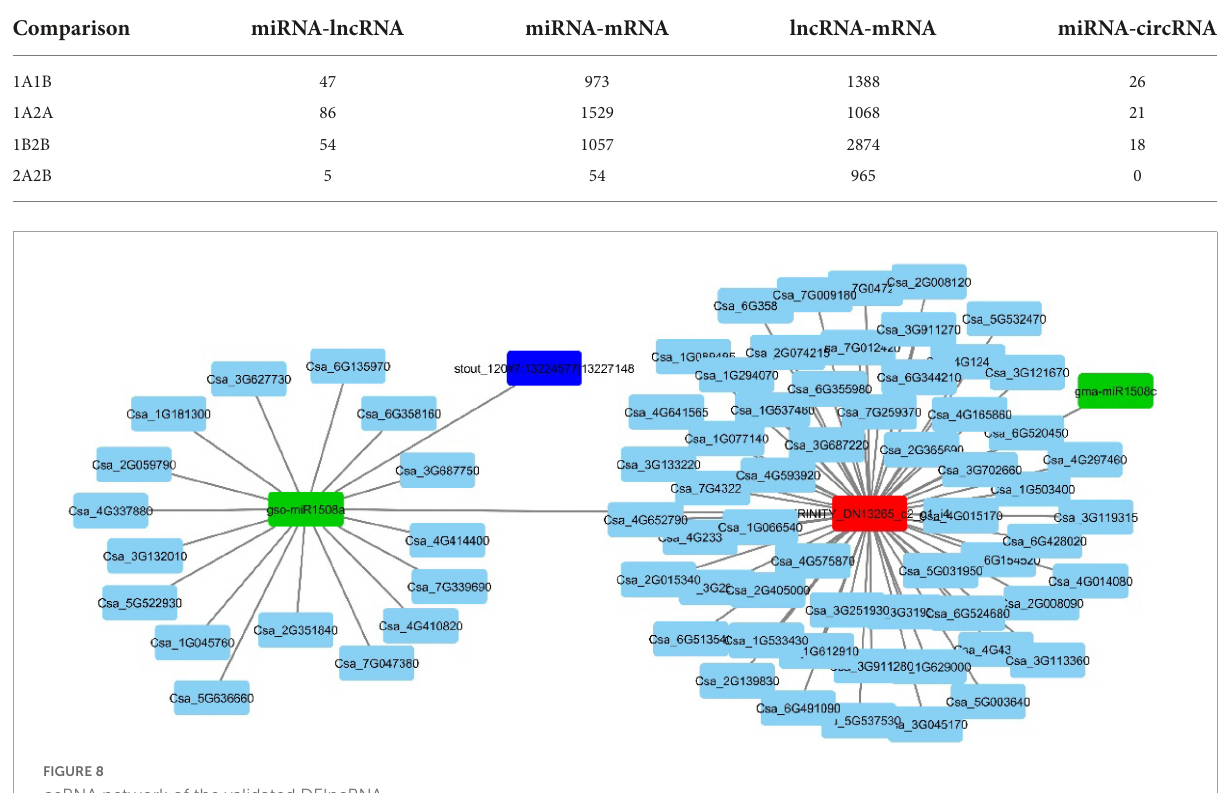
TABLE 3 Number of interactions in the ceRNA network.